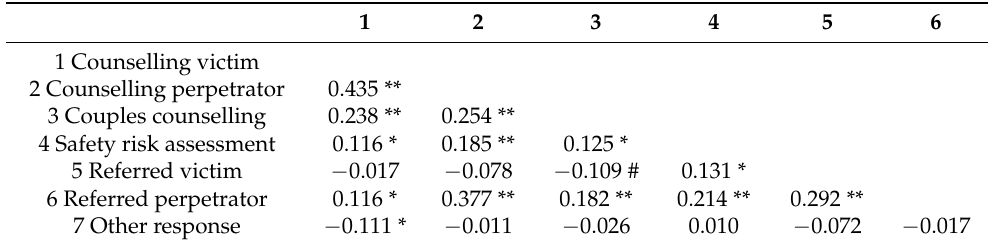
Table 3. Pearson’s correlation coefficients between responses to DFV (among leaders who had responded to